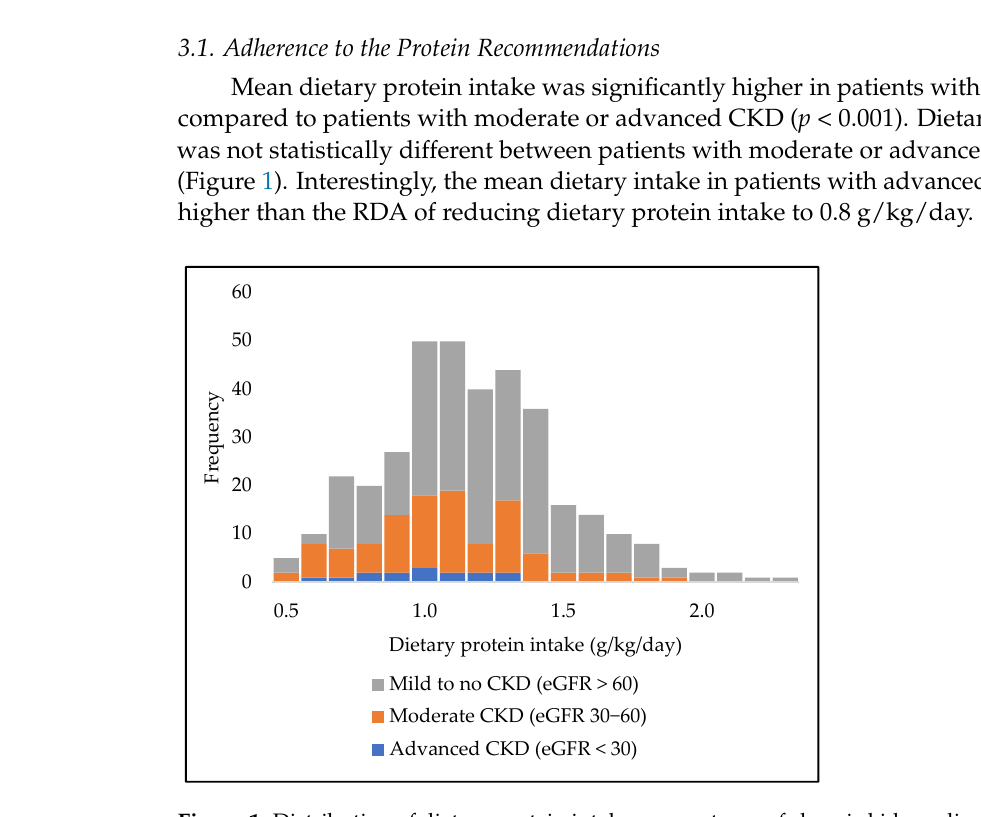
Figure 1. Distribution of dietary protein intake across stages of chronic kidney disease in the Diabetes and Lifestyle Cohort Twente.